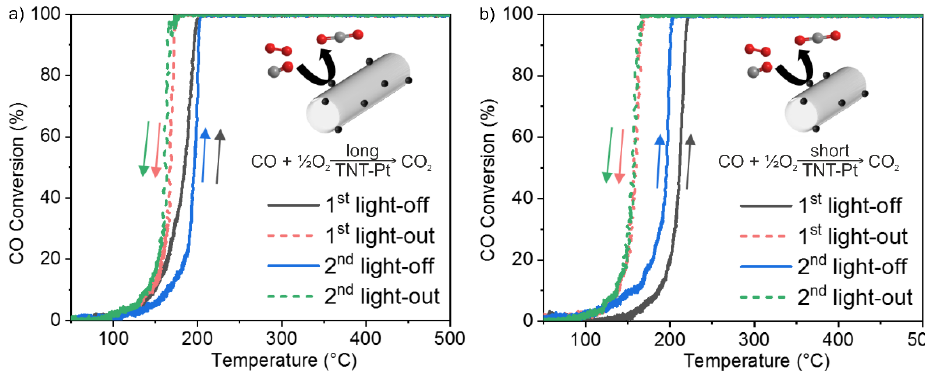
Figure 6. Catalytic CO oxidation with Pt/TNTs (1 wt-%) with ( a ) long Pt/TNTs and ( b ) short Pt/TNTs.